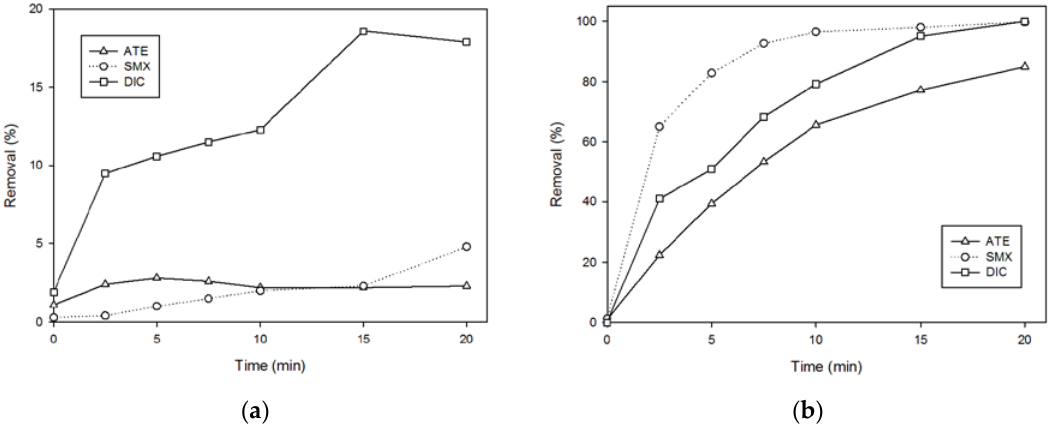
Figure 2. Removal efficiencies of single pharmaceuticals in a 1 L batch reactor with a 5-cell system of ( a ) aluminum or ( b ) graphite ([Phar.] 0 = 100 µM, [NaCl] = 0.01 M, I = 0.5 A).